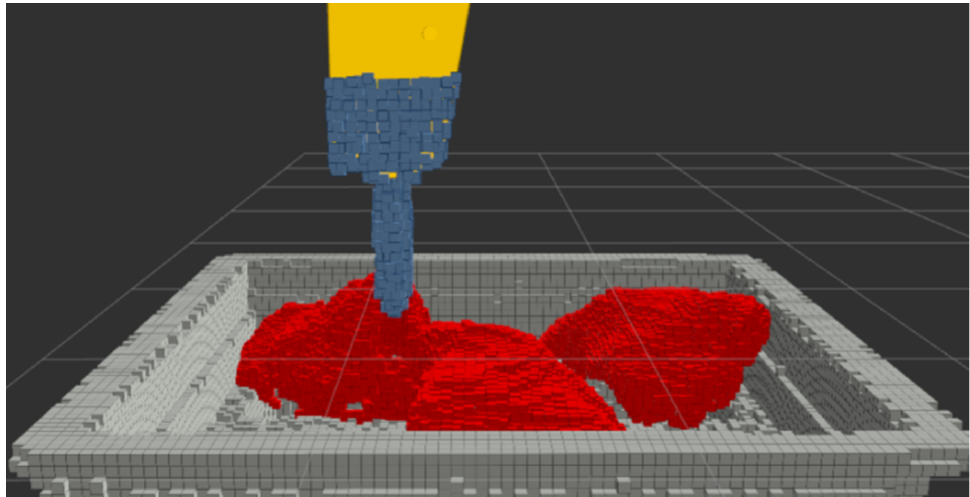
Figure 4. Point cloud categorization. Environment points (in gray) and material points (in red). Hammer points in blue, showed over the end-effector model (in yellow).